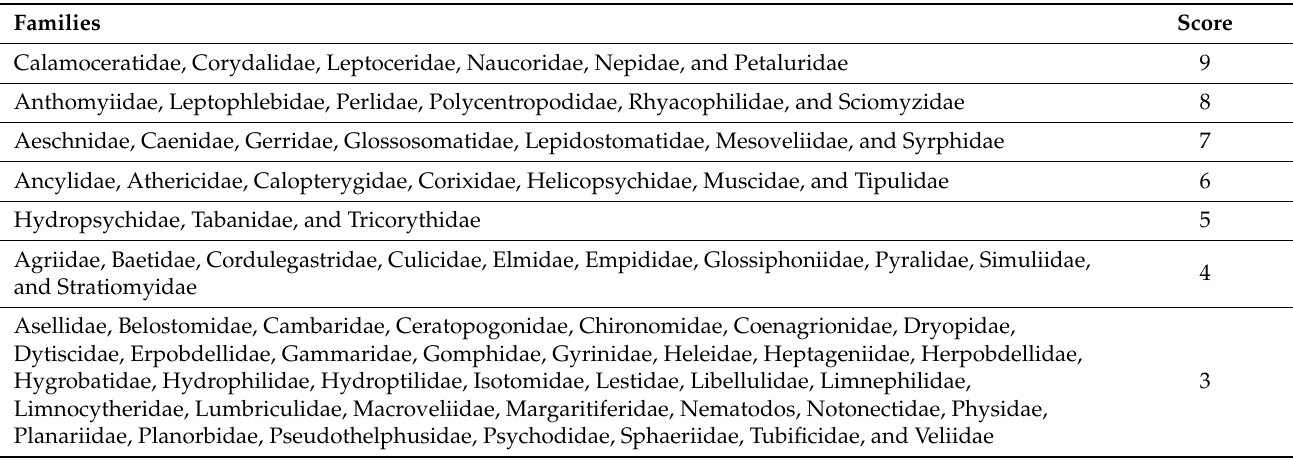
Table 2. Bioindication values were modified and adapted to the different families found in the Duero river as part of the BMWP calibration. Families Score Calamoceratidae, Corydalidae, Leptoceridae, Naucoridae, Nepidae, and Petaluridae